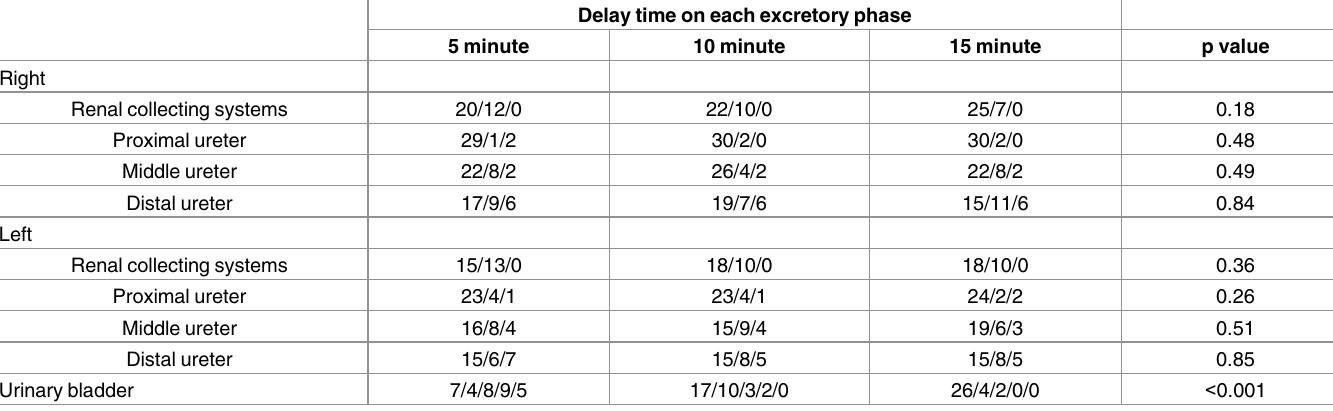
Table 1. Opacification scores of the urinary